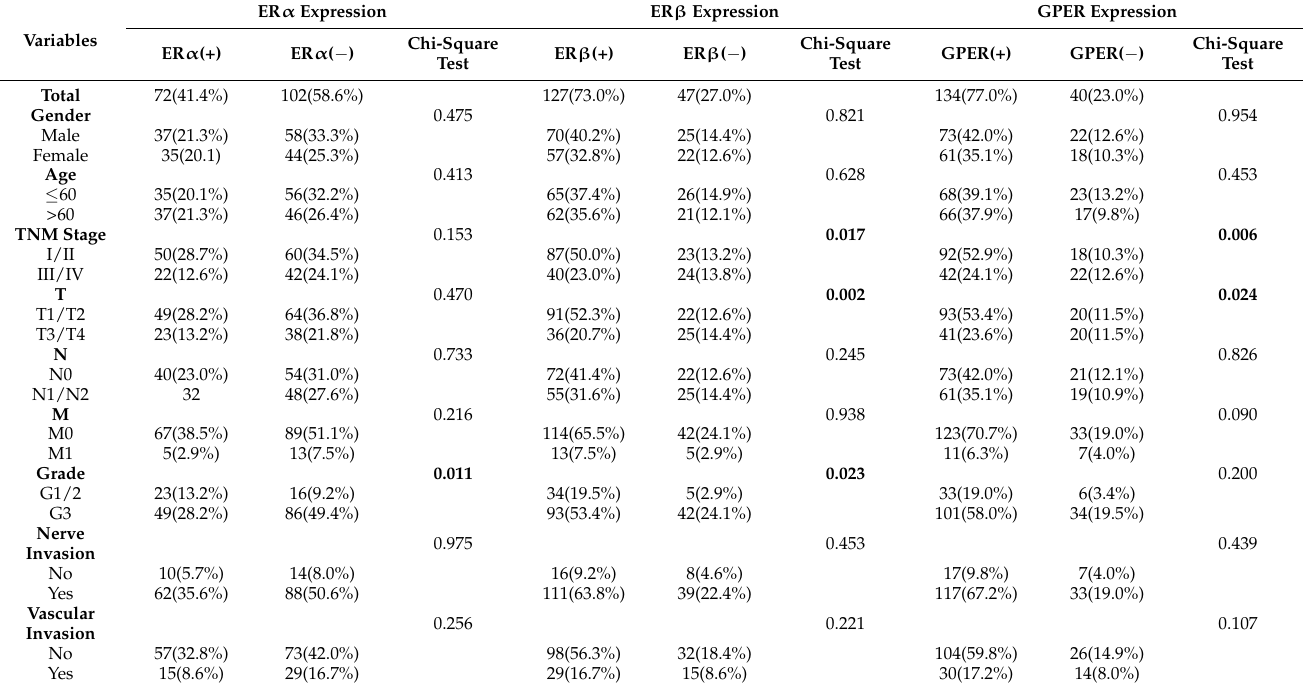
Table 1. Expression of ERs in PAAD and its association with patients‘ clinicopathological